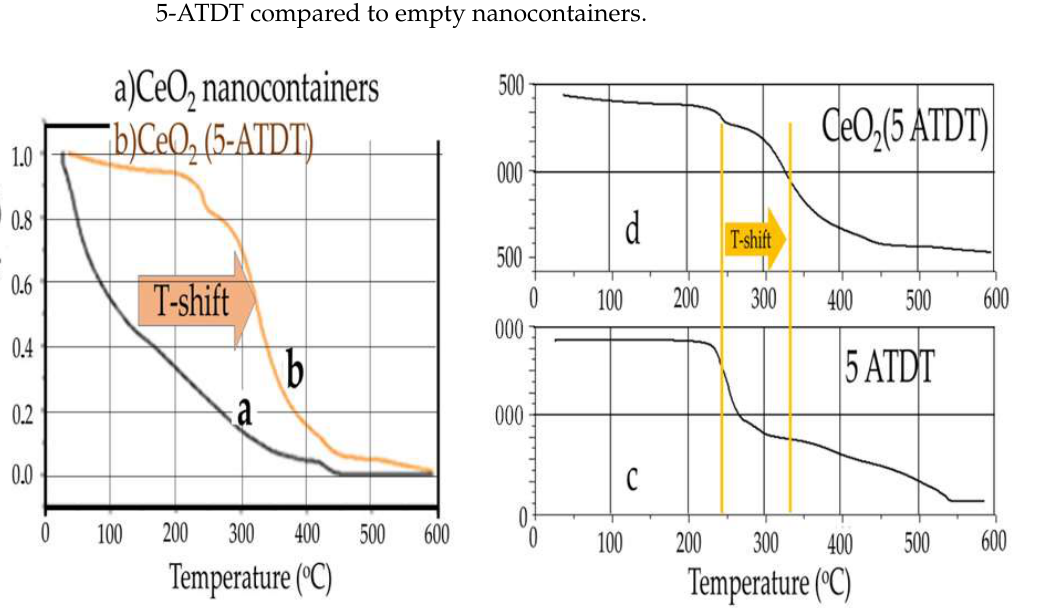
Figure 4. TGA diagrams of ( b , d ) CeO 2 (5-ATDT), ( a ) CeO 2 (empty) nanocontainers and ( c ) 5-ATDT alone. T-Shift due to delayed burning of 5-ATDT, the weight loss corresponds to the loaded mass into the nanocontainers.